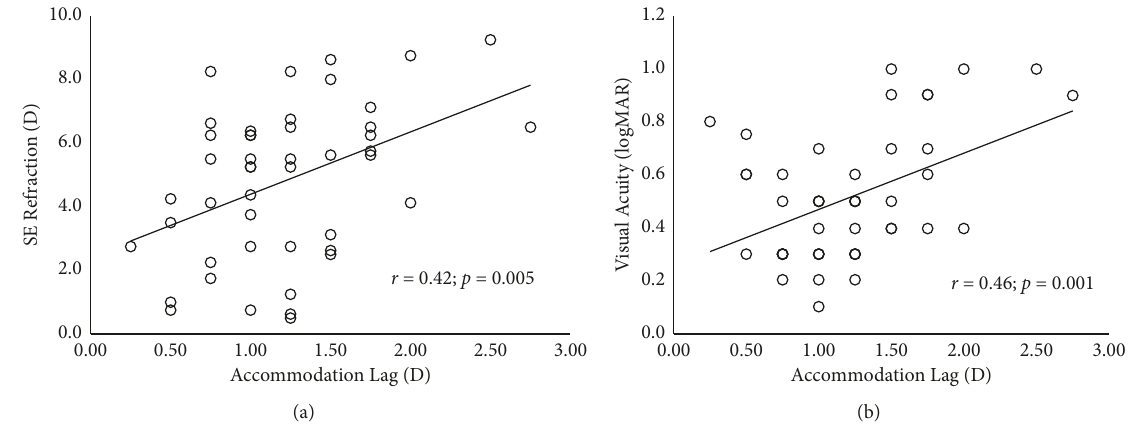
Figure 2: Correlation of monocular accommodation lag with spherical equivalent (SE) refraction (a) and visual acuity (b) of the amblyopic eye. Some data points (circles) may represent over-laid multiple